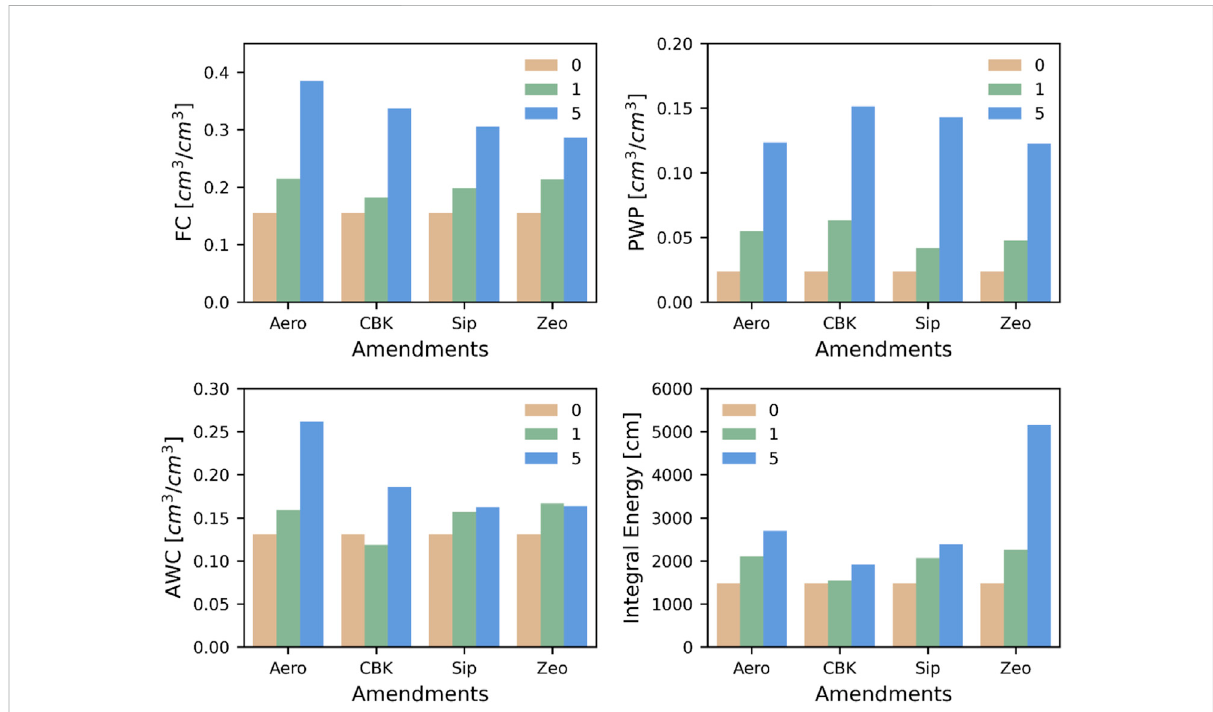
FIGURE 2 Different ASi amendments increase fi eld capacity (FC), permanent wilting point (PWP), available water (AW) and integral energy of sandy soil. This data was extracted from the fi tted soil retention curves (Figure